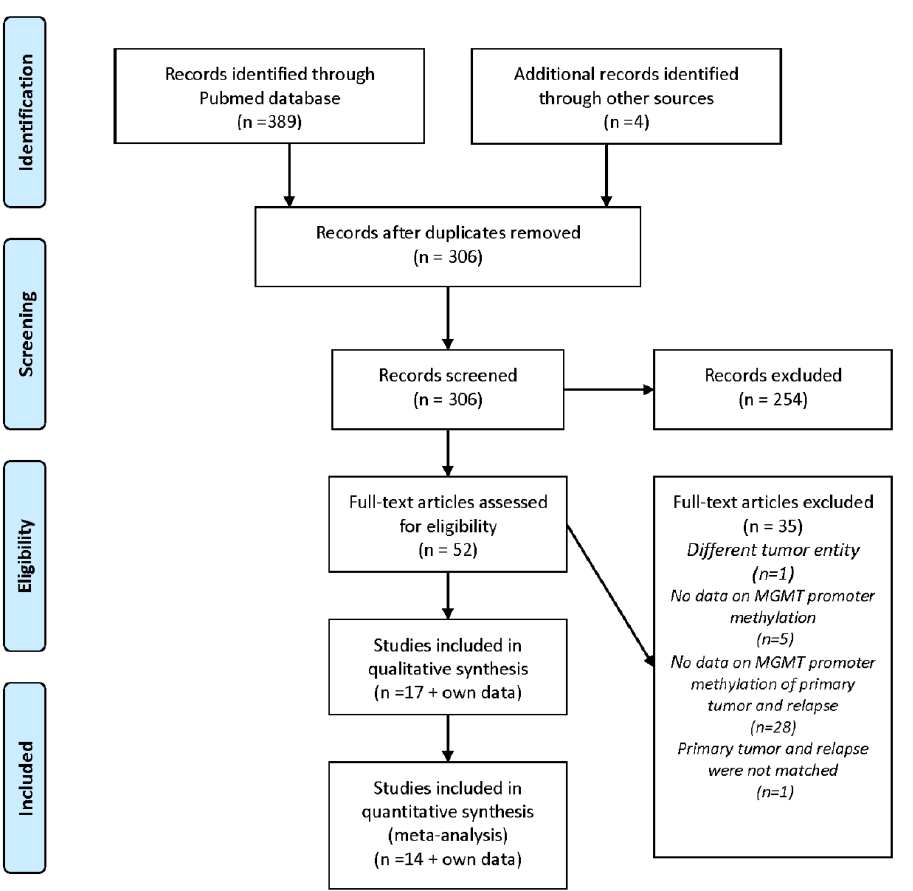
Figure A1. PRISMA guidelines for methodological review of literature related to MGMT promoter methylation changes in glioblastoma relapse.